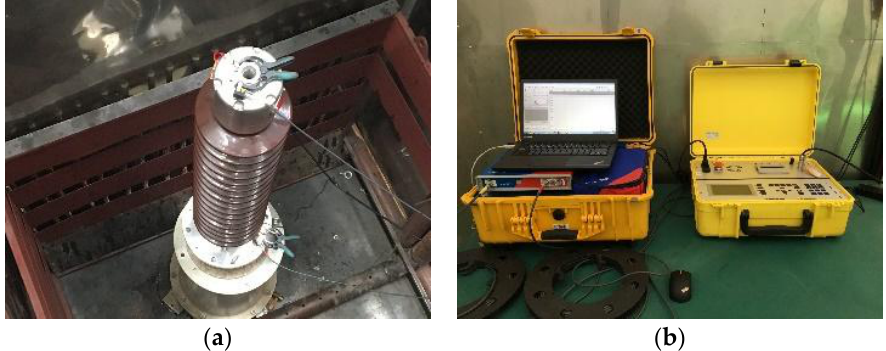
Figure 4. ( a ) OIP condenser bushing placed in an oast house for tests; ( b ) dielectric response analyzer and recovery voltage meter.